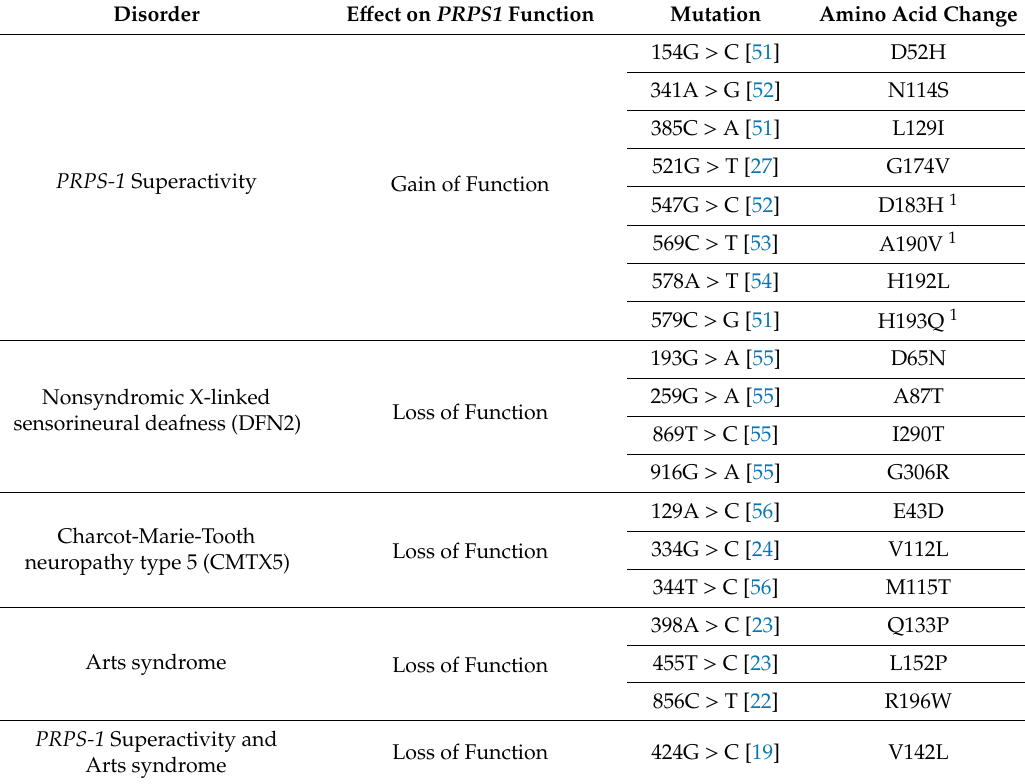
Table 1. Missense mutations identified in phosphoribosyl pyrophosphate synthetase 1 ( PRPS1 ) associated with PRPS1 -associated neurological